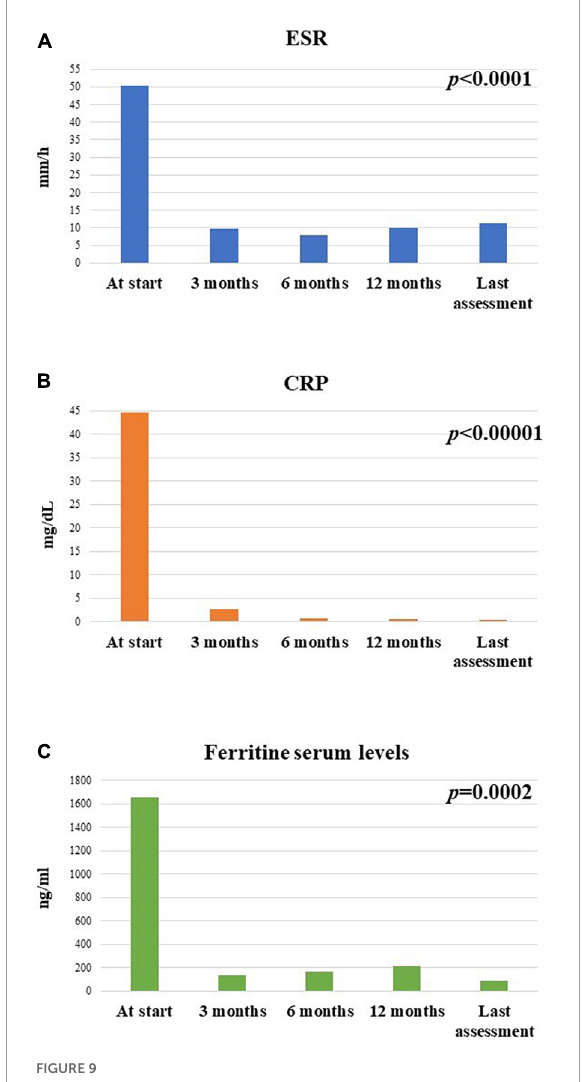
FIGURE9 Mean (A) erythrocyte sedimentation rate (ESR), (B) C-reactive protein (CRP), and (C) ferritin serum levels at the different timepoints in the group of 26 patients enrolled in the